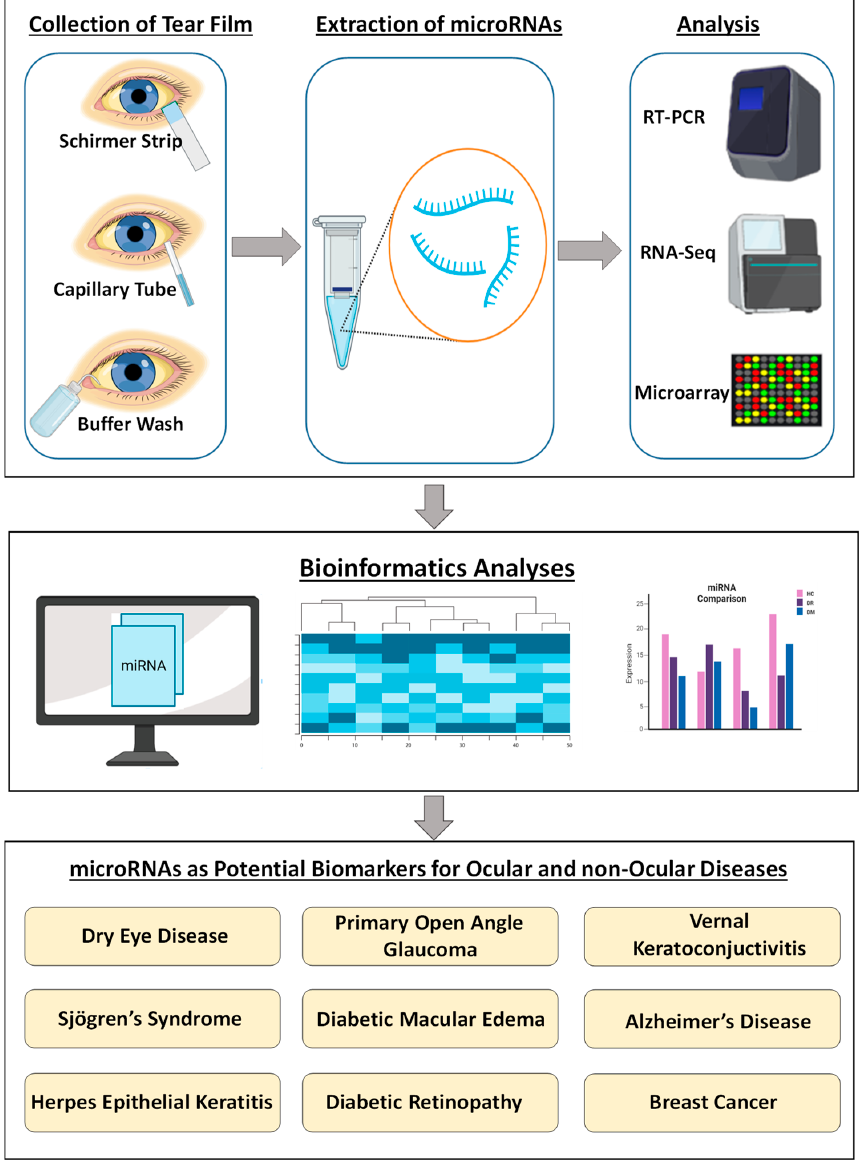
Figure 1. Overall pipeline for the discovery of tear film miRNAs as biomarkers.